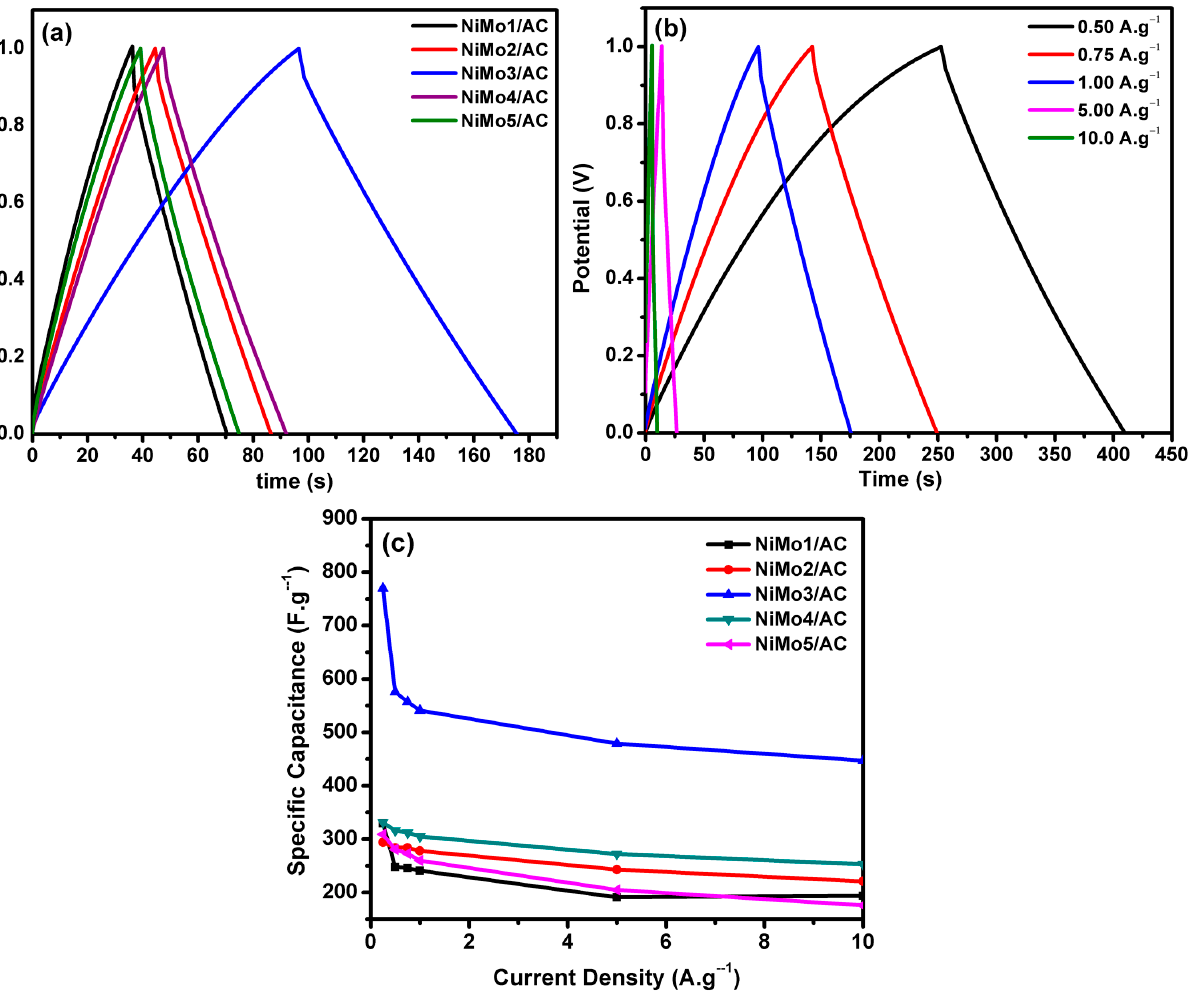
Figure 10. ( a ) The galvanostatic charge-discharge curves for all of the electrodes at a current density of 1 A · g − 1 , ( b ) the galvanostatic charge-discharge plots of NiMo3/AC at various current densities, ( c ) the change in specific capacitance with the applied current density. Figure 11a represents the Nyquist plots for AC, NiMo1/AC, NiMo2/AC, NiMo3/AC, NiMo4/AC, and NiMo5/AC measured within the frequency range of 10 mHz–100 kHz.